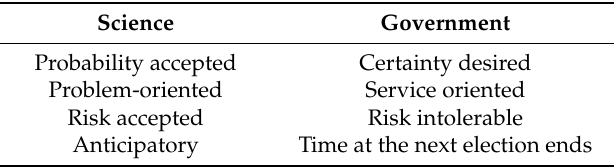
Table 1. Characteristics of science and